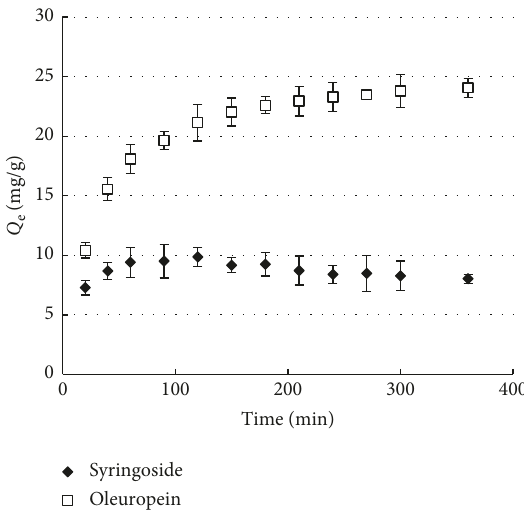
Figure 3: Adsorption kinetics curves of syringoside and oleuropein on the HPD-100B